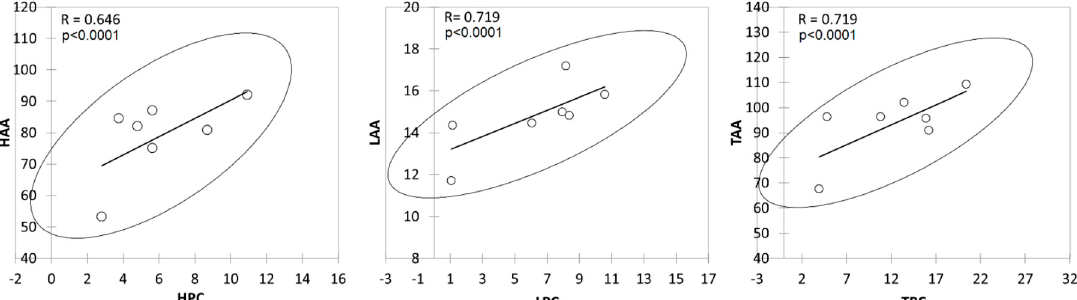
Figure 4. Total phenol, antioxidant, and oxidant content in natural soaps following cold saponification. ( a , d , g ) Hydrophilic, ( b , e , h ) lypophilic, and ( c , f , i ) total phenolic content, antioxidants activity, and oxidant content, respectively, in commercial soaps. Values represent means ± standard errors. Means in the same row accompanied by different letters are significantly different between treatments at LSD = 0.05, n = 4 per experimental replicate. Natural soap acronyms: BB = base bar (control), FG = forest grove, H = hibiscus rose hip, FGA = forest grove + essential oils and green clay, HA = hibiscus + essential oils and pink clay, BBR = base bar + rosemary, FGR = Forest grove + rosemary, HR = hibiscus + rosemary, HOS = hydrophilic oxidant status, LOS = lipophilic oxidant status, TOS = total oxidant status, HPC = hydrophilic phenolic content, LPC = lipophilic phenolic content, TPC = total phenolic content, HAA = hydrophilic antioxidant activity, LAA = lipophilic antioxidant activity, TAA = total antioxidant activity.